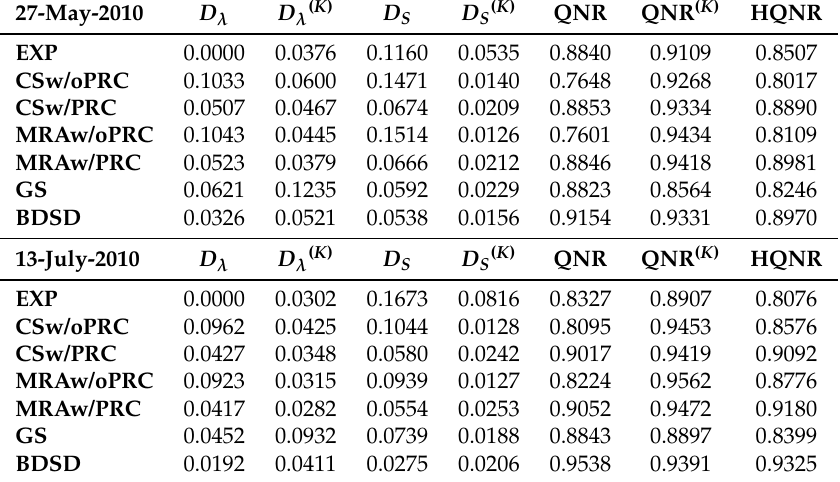
Table 1. Full-scale spectral/spatial distortion indexes and cumulative scores. GS stands for Gram–Schmidt spectral sharpening (see [16]) and BDSD for band-dependent spatial detail